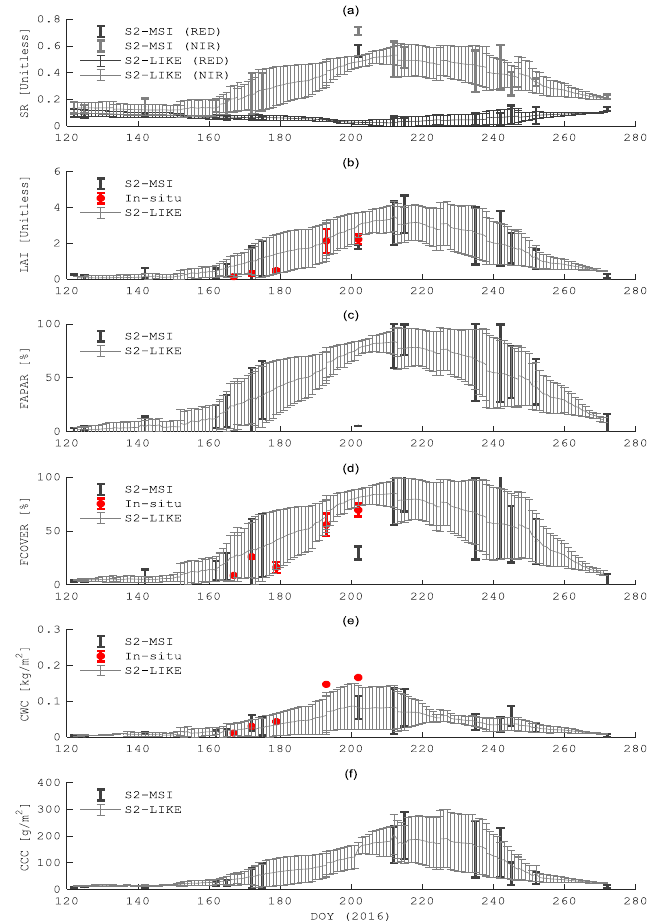
Figure 8. Time series of ( a ) surface reflectance (SR) data (RED and NIR bands), ( b ) LAI, ( c ) FAPAR, ( d ) FCOVER, ( e ) CWC, and ( f ) CCC from S2-LIKE images, S2-MSI images, and in situ measurements (for LAI, FCOVER, and CWC).